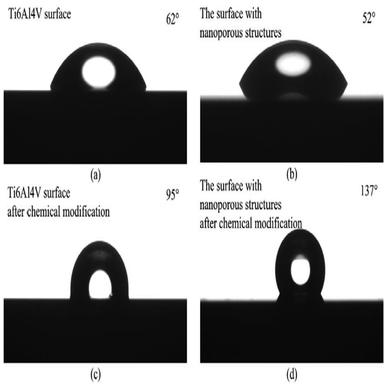
Contact angles of (a) the polished Ti6Al4V surface, (b) the surface with nanoporous structures, (c) the polished Ti6Al4V surface after chemical modification, and (d) the surface with nanoporous structures after chemical modification.